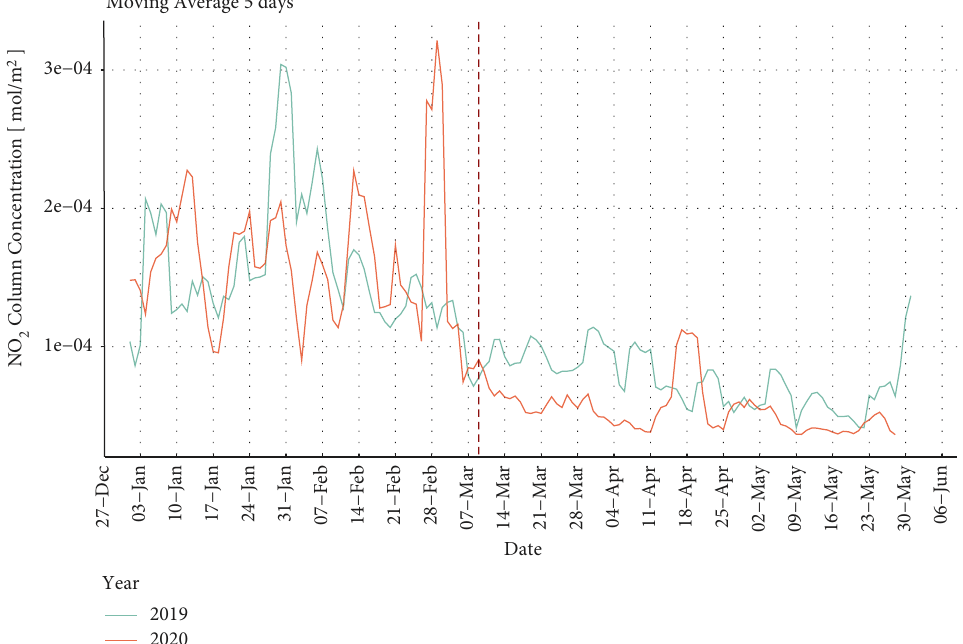
Figure 2: Comparison of NO